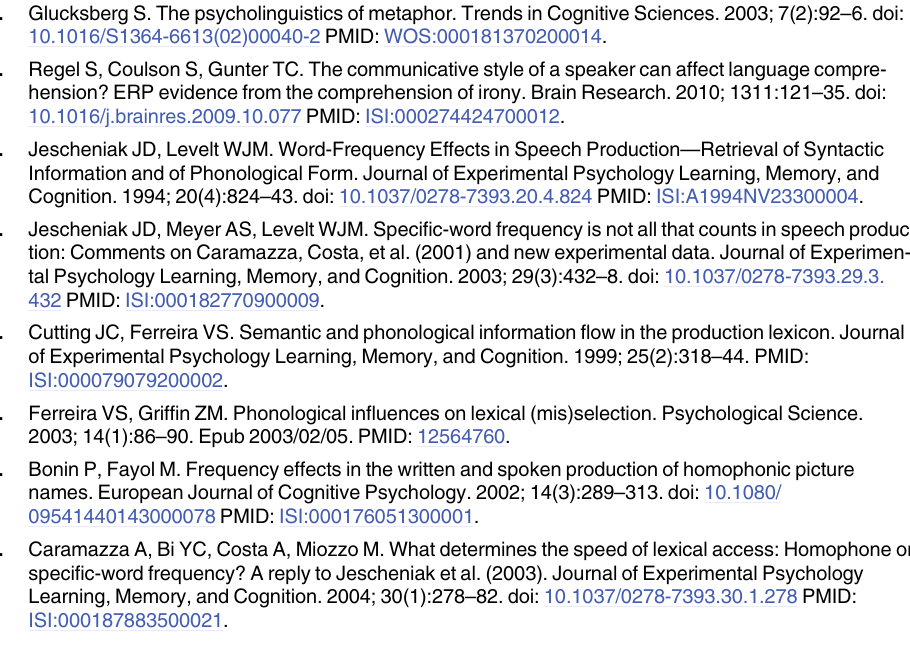
S1 Table. Used stimuli material.